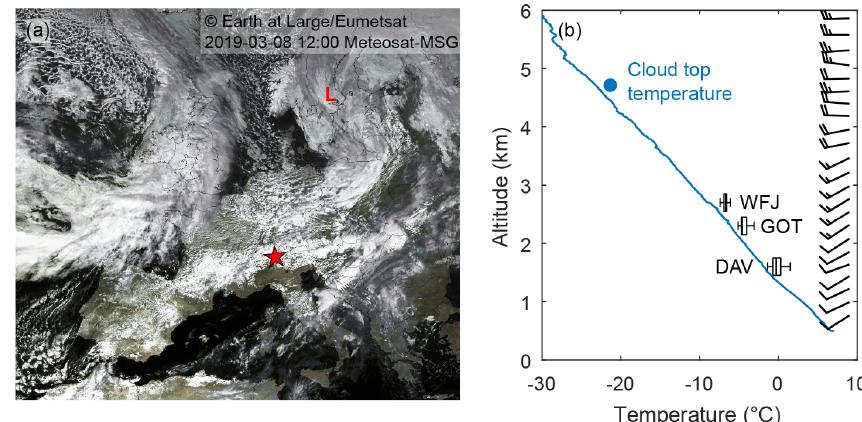
Figure 2. Overview of the synoptic weather situation on 8 March 2019, showing a satellite picture taken over Europe at 12:00UTC ( a , EU- METSAT) and the vertical temperature profile measured by a radiosonde (12:00UTC) launched from Payerne ( b , MeteoSwiss). The boxplots in (b) indicate the temperature measured at the weather stations of Davos (DAV, 1600m), Gotschnagrat (GOT, 2300m) and Weissfluhjoch (WFJ, 2700m) during the passage of the cloud system. The blue dot indicates the cloud top temperature ( − 21 ◦ C) and cloud top height (4700m), which were estimated from the cloud radar observations averaged between 16:00 and 18:00UTC. The wind barbs are shown on the right